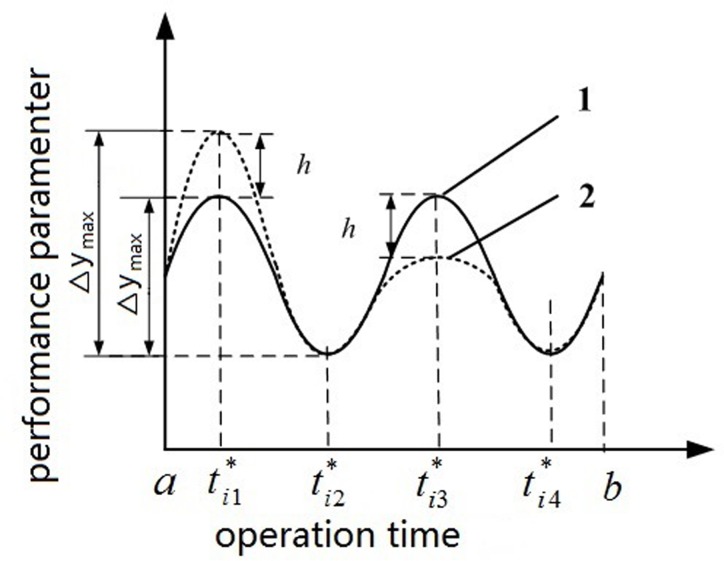
Diagram of performance parameter’s stability(a).